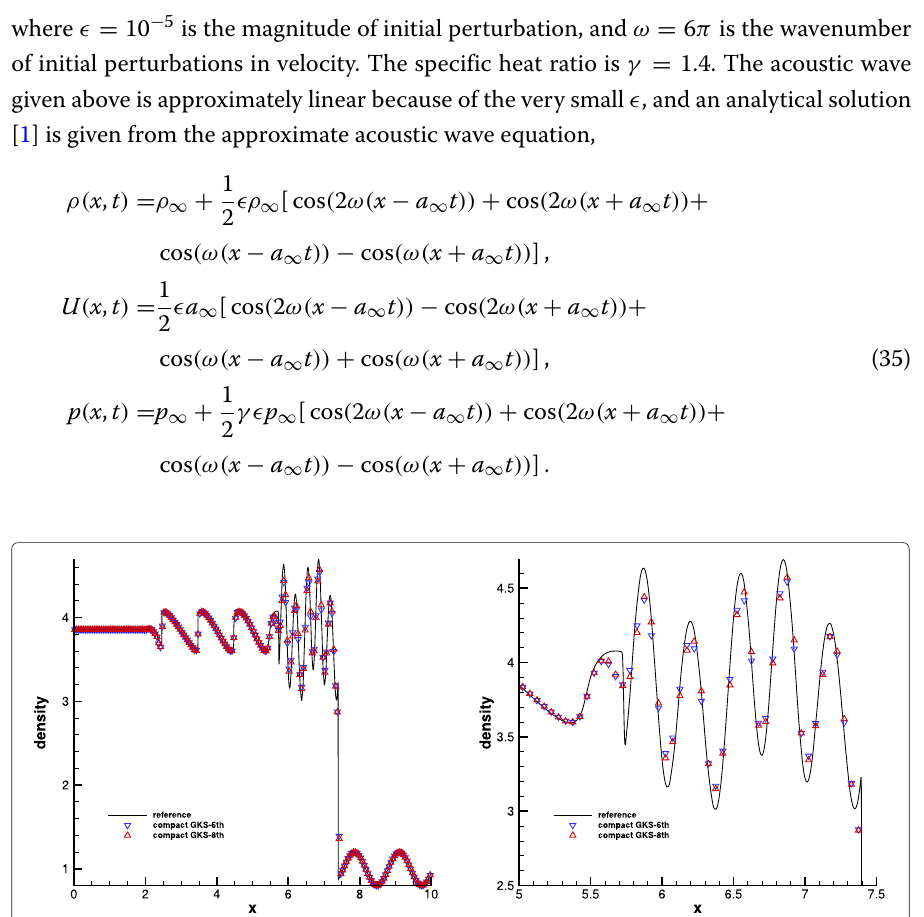
Fig. 5 Shu-Osher problem: the density distribution and local enlargement by 6th-order and 8th-order compact GKS at t = 1.8 with 200 mesh